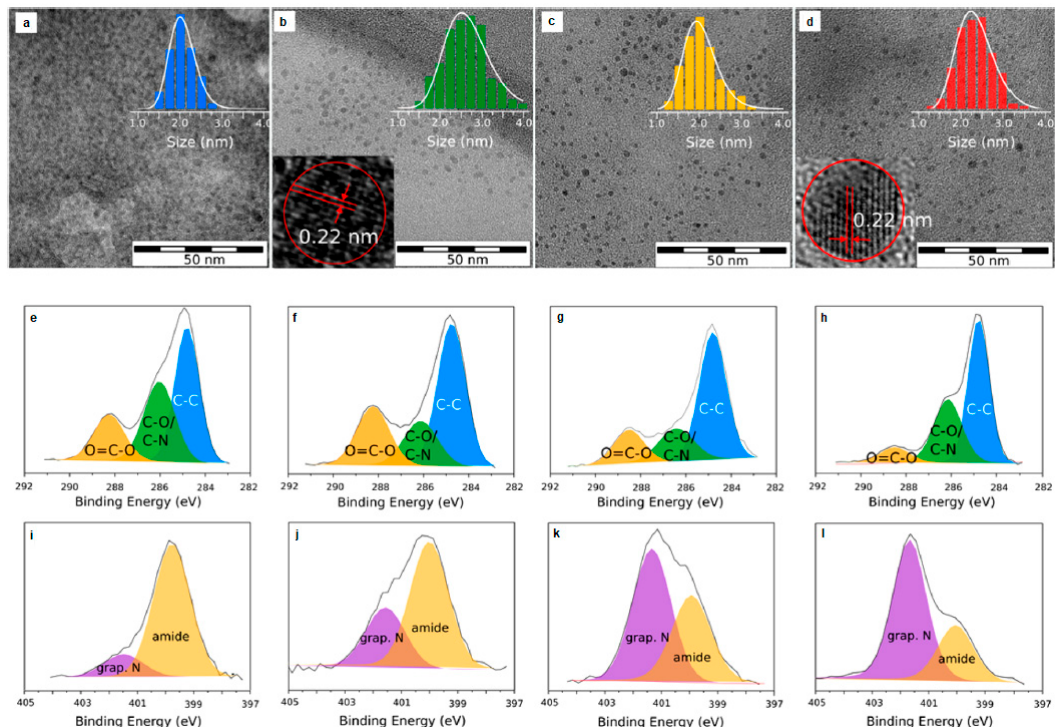
Figure 2. TEM images of: ( a ) b-C-dots, ( b ) g-C-dots, ( c ) y-C-dots and ( d ) r-C-dots with diameter histogram and HR-TEM images for g-C-dots and r-C-dots in the inset. High-resolution C 1s and N 1s XPS spectra for ( e , i ) b-C-dots; ( f , j ) g-C-dots; ( g , k ) y-C-dots and ( h , l ) r-C-dots. Reprinted (adapted) with permission from [39]. Copyright 2021 American Chemical Society.